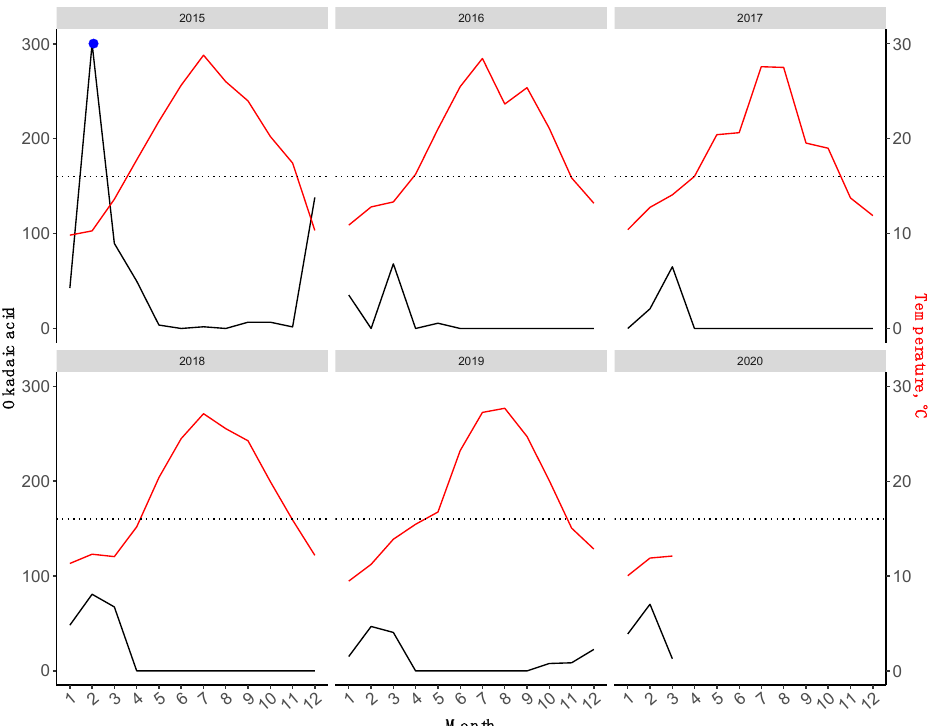
Figure 3. The annual trend of okadaic acid according to the temperature. Each blue dot indicates a value exceeding 160 μ g eq OA/kg e.p.